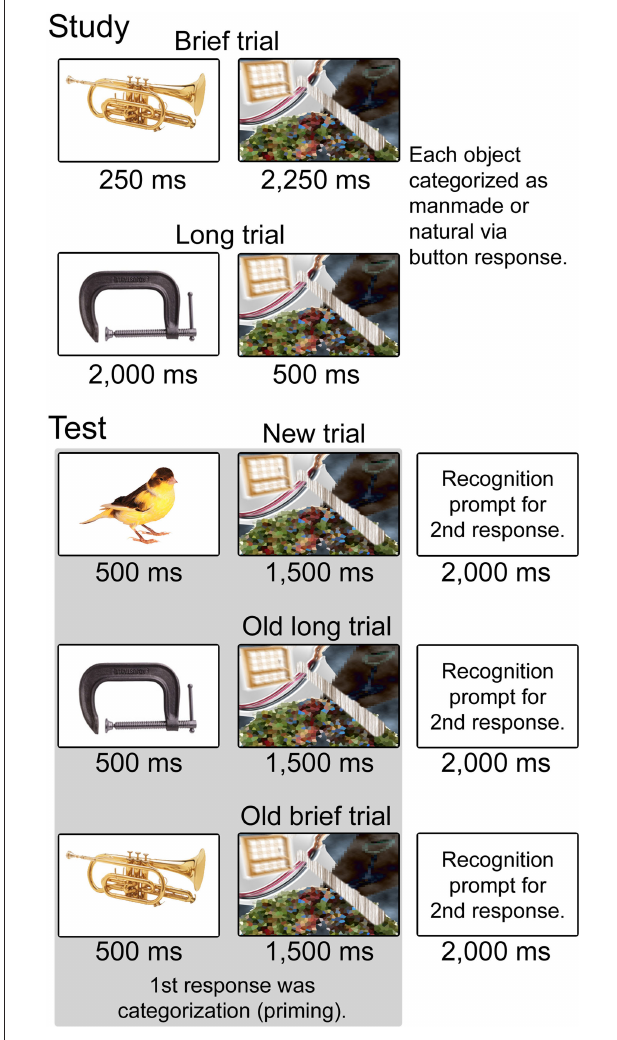
Figure 1 | Schematic representation of trial types during study and test. Conditions during study included Brief (250 ms object presentation) and Long (2,000 ms object presentation). Objects in each condition were followed by a mask such that trial duration was 2,500 ms for both conditions. Subjects categorized each object as “natural” or “manufactured.” Conditions during test included Brief and Long objects repeated from the study phase as well as new objects. Objects in all conditions were presented for 500 ms with a 1,500 ms mask. Two behavioral responses were registered for each object. The first was a categorization response to measure priming, made as soon as possible after the stimulus was presented. The second was a recognition response including four confidence levels, made to a prompt that followed the